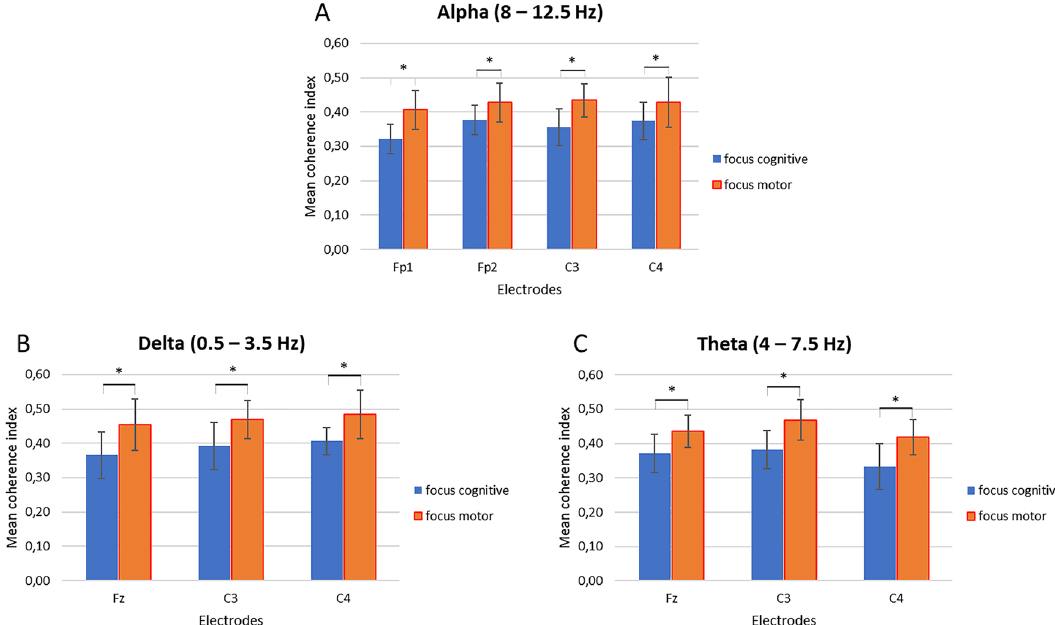
Figure 5. ( A – C ) Mean coherence indices for alpha, delta, and theta frequency bands. Bar graphs show the mean values of coherence indices (± SE) for the alpha ( A ), delta ( B ), and theta ( C ) band under the focus condition during the motor compared to the cognitive synchronization task. All asterisks (*) mark statistically significant differences, with p ≤